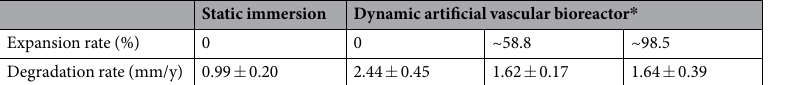
Table 2. Average degradation rates of Mg-based helical stent under in vitro . * Flow rate (mL/min) was operated according to the wall shear stress of 0.68 Pa.